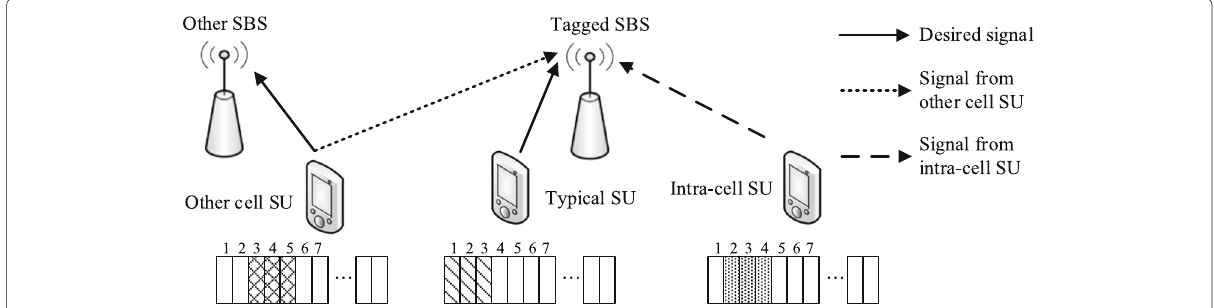
Fig. 1 When the DSA is adopted, there exist interferences from not only other cell SUs but also from intra-cell SUs